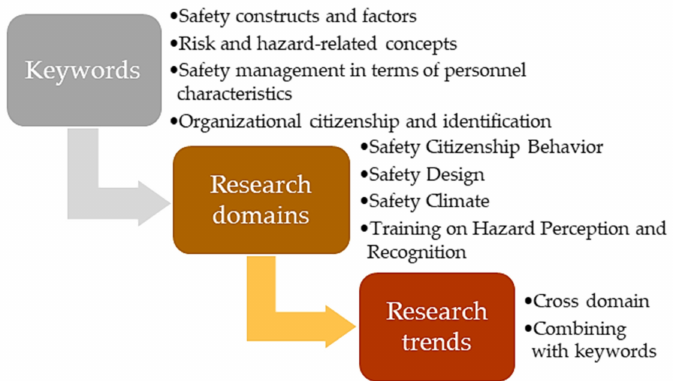
Figure 11. Framework for proposing further research trends and orientation for occupational safety in